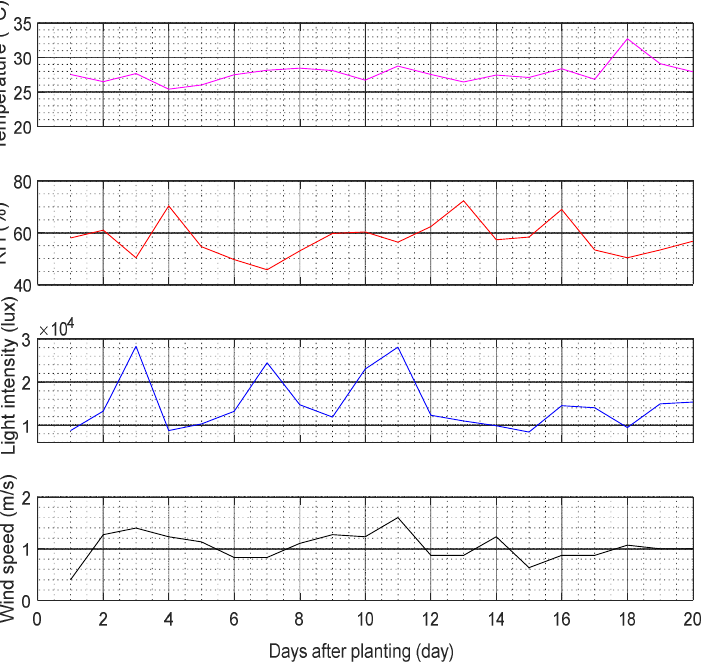
Figure 2. Fluctuations in microclimate conditions in the rooftop greenhouse during spinach cultiva- tion.